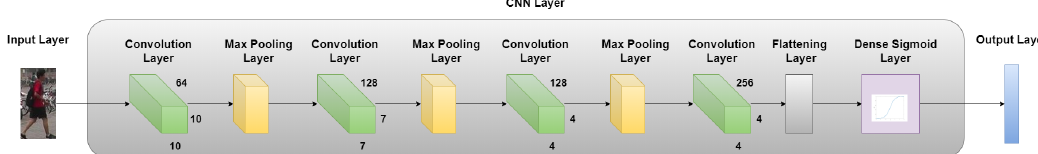
Figure 3. Convolutional Neural Network (CNN) architecture as utilised within the Siamese network of the current